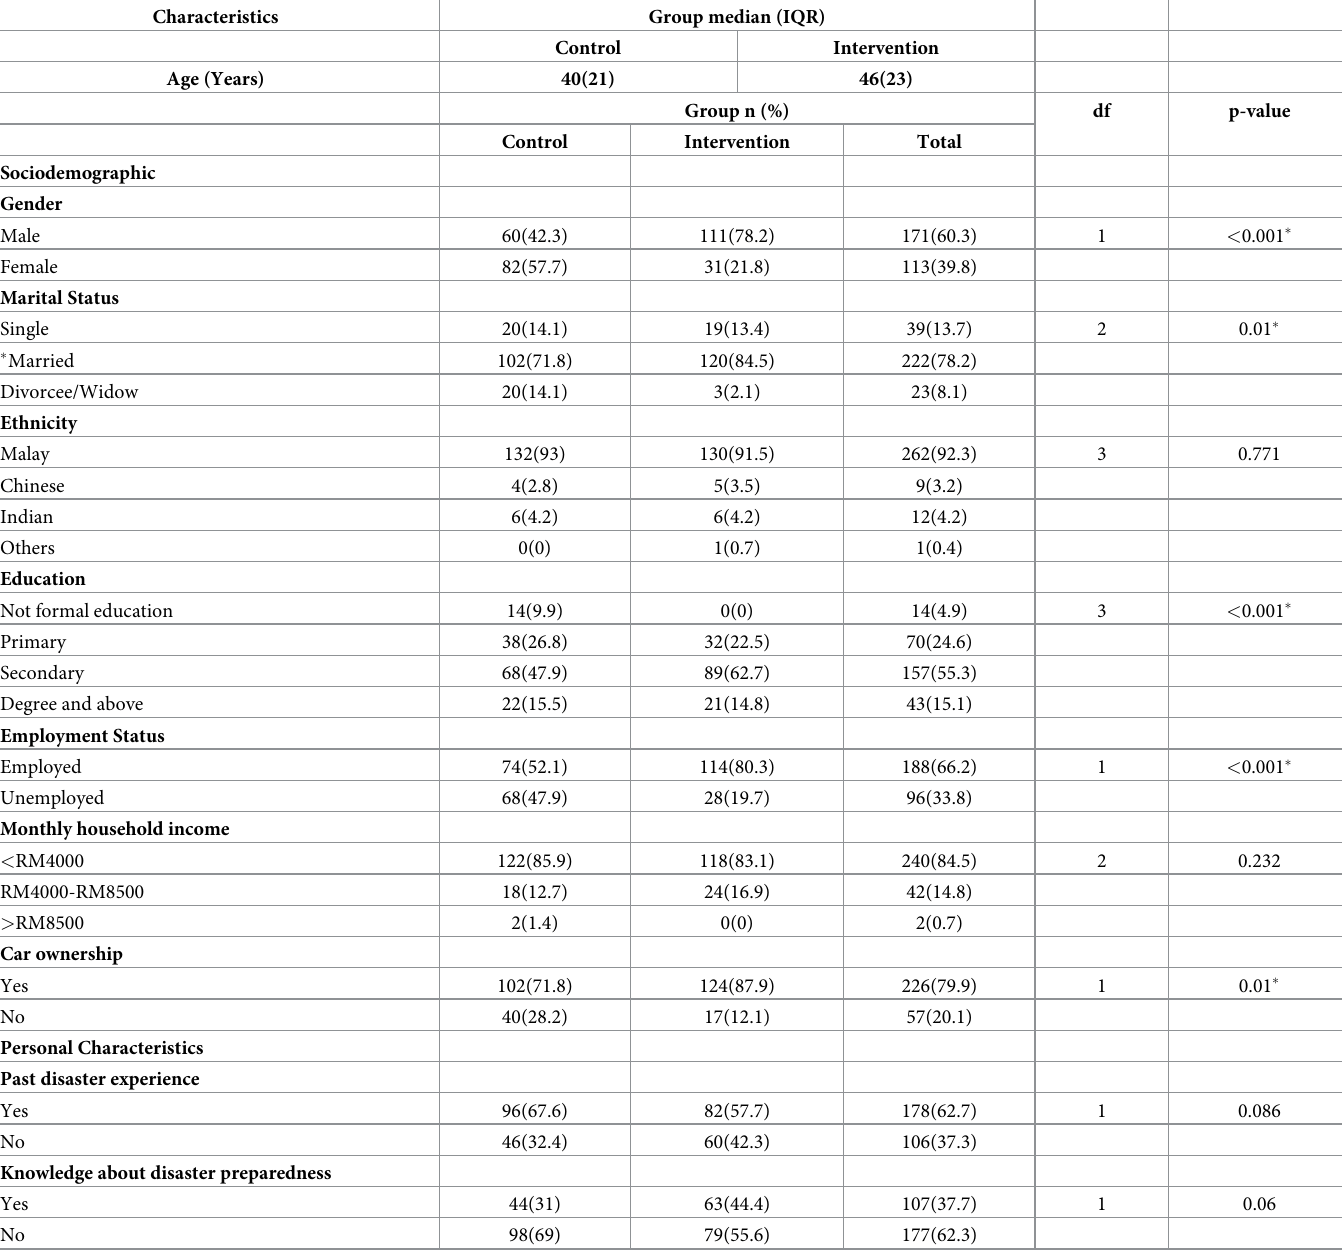
Table 2. Baseline comparison of sociodemographic characteristics of participants between the intervention and control